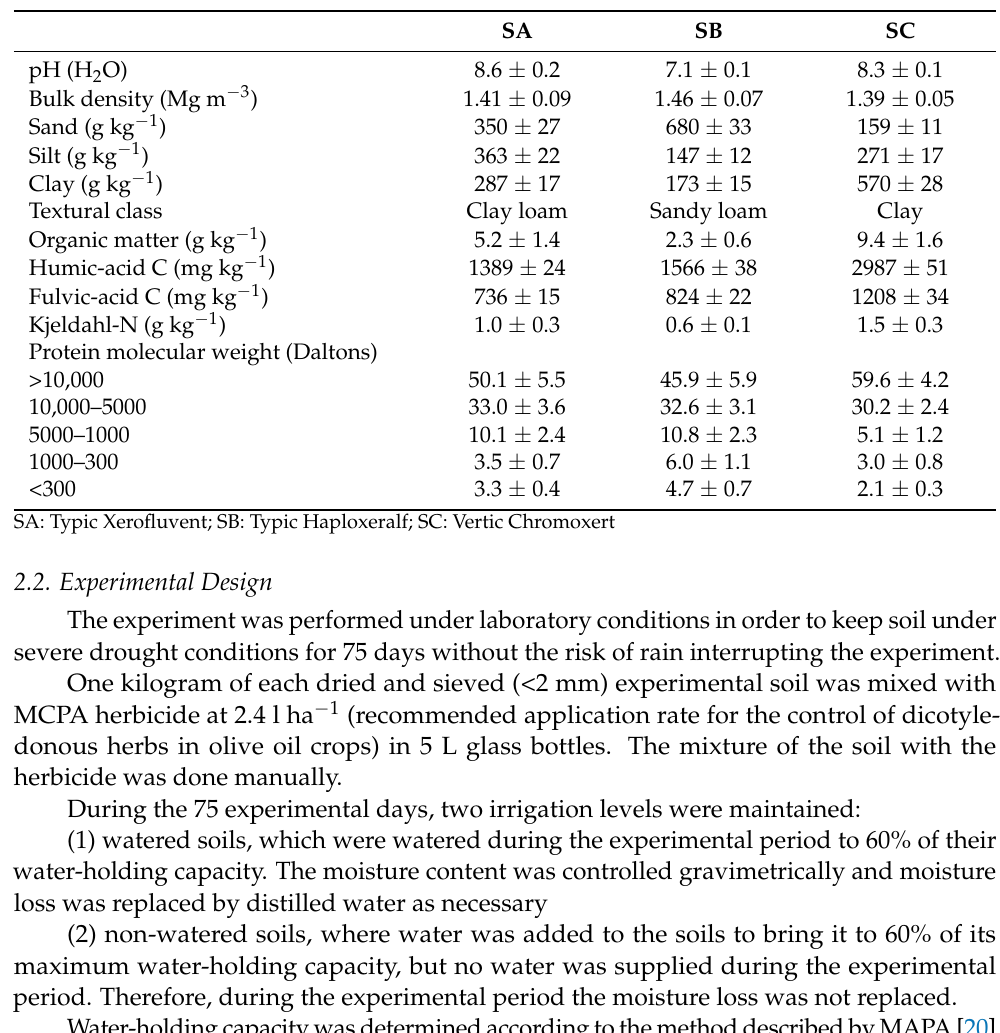
Table 1. Characteristics of the experimental soils (mean ± standard deviation, n =